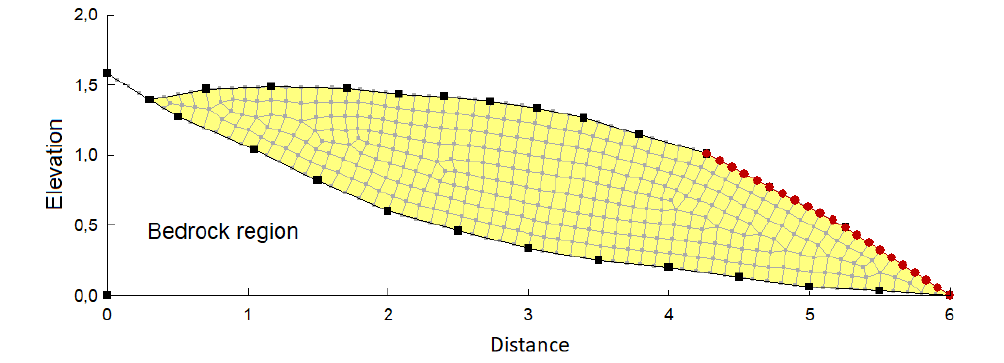
Figure 8. Mesh generation of finite element model